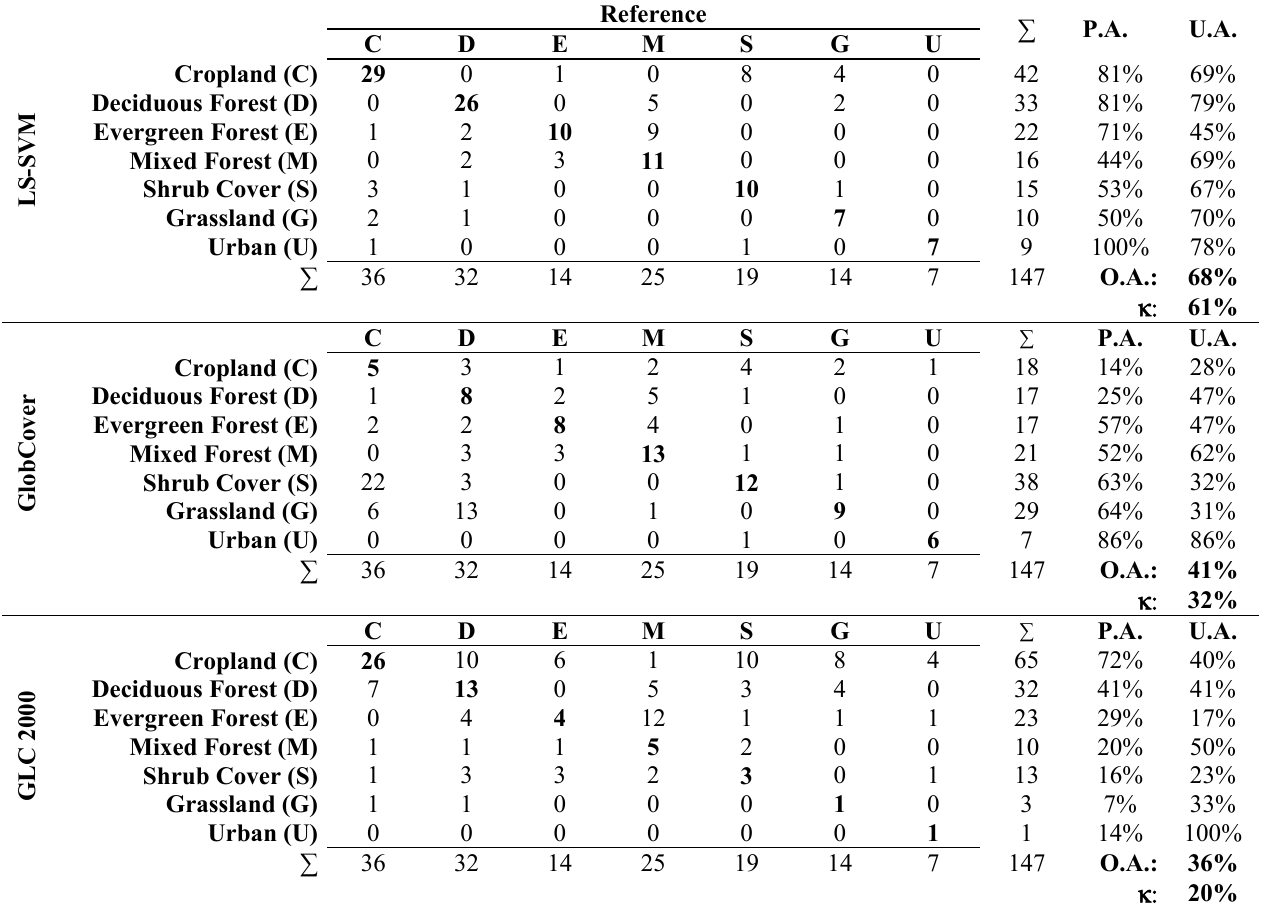
Table 6. Error matrices and statistical measures for LS-SVM and GlobCover/GLC2000 for the disagreement data points (n = dis